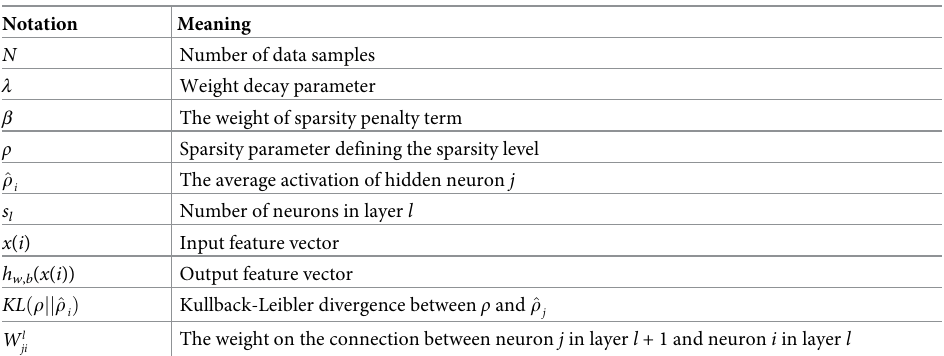
Table 1. The notations utilized in the cost